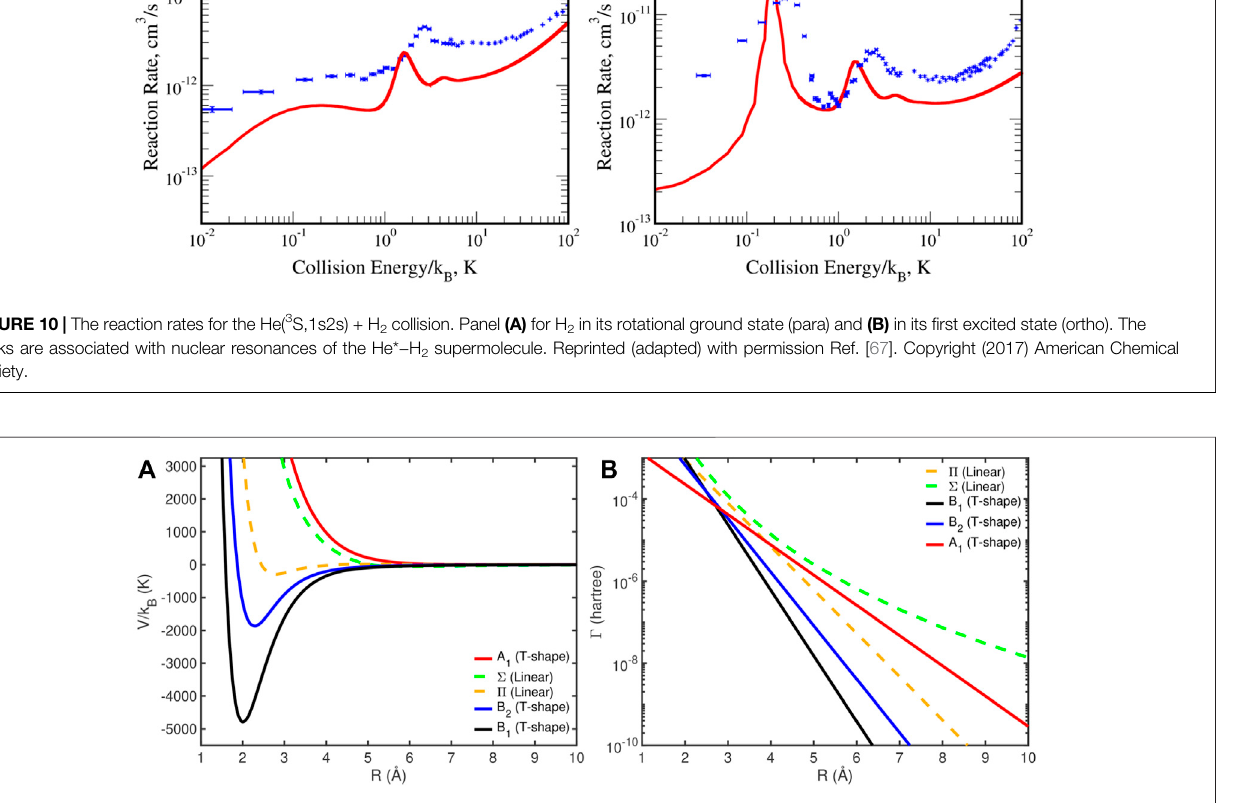
FIGURE11| TheRVP complexpotentialenergy surfaceofHe( 3 P,1s2p)+H 2 inT-shapeand linear geometries. Therealpart (Re E ( R ))ispresentedinpanel (A) . The decay rate ( Γ ( R ) = − 2Im E ( R )) is presented in panel (B) in logarithmic scale. Reprinted (adapted) with permission Ref. [68]. Copyright (2019) American Chemical Society.